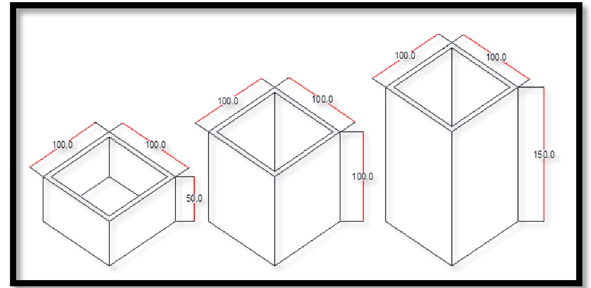
Figure 4: Dimension of a used skirt ( mm )